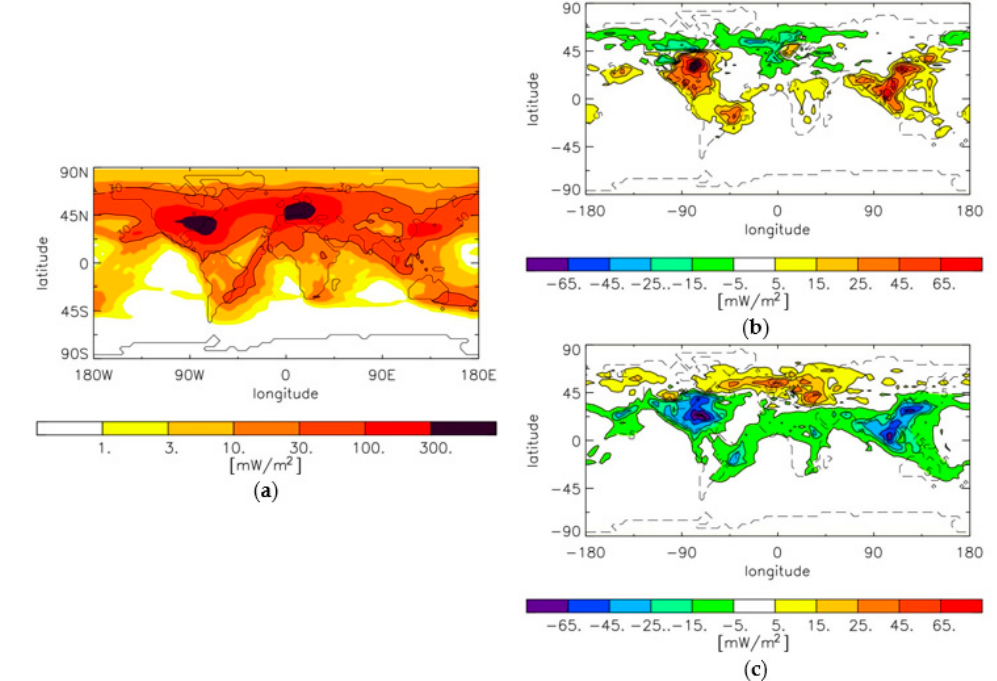
Figure 5. Contrail cirrus radiative forcing for the control inventory ( a ) and difference between the Flying higher inventory ( b ) and the Flying lower inventory ( c ) as simulated by ECHAM4-CCMod [27].